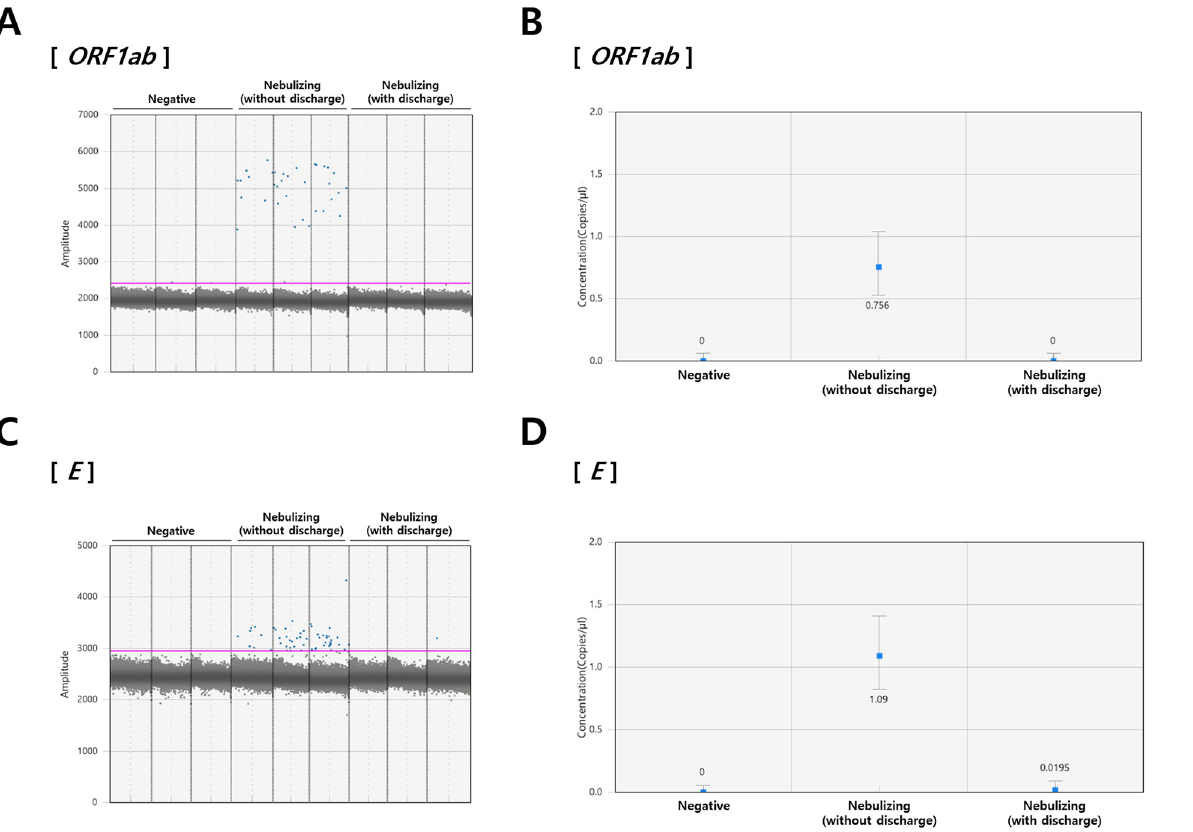
Fig 4. Quantification of SARS-CoV-2 viral genes. SARS-CoV-2 (A, B) ORF1ab and (C, D) E were detected in the nebulized samples using droplet digital polymerase chain reaction and quantified using the QuantaSoft software. (A, B) Each blue dot represents a droplet containing fluorescein- labelled DNA fragments. (C, D) Error bars indicate the 95% Poisson confidence intervals for each measurement.